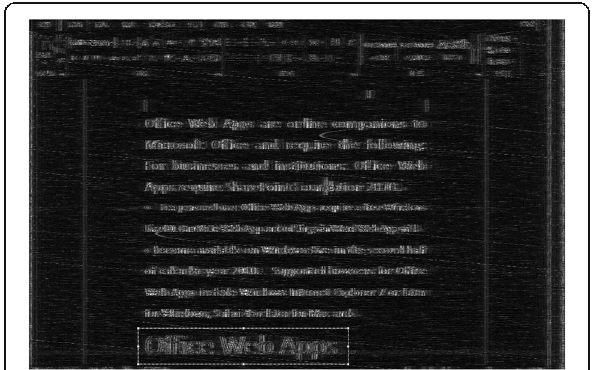
Fig. 9 Selected area of the image at frame